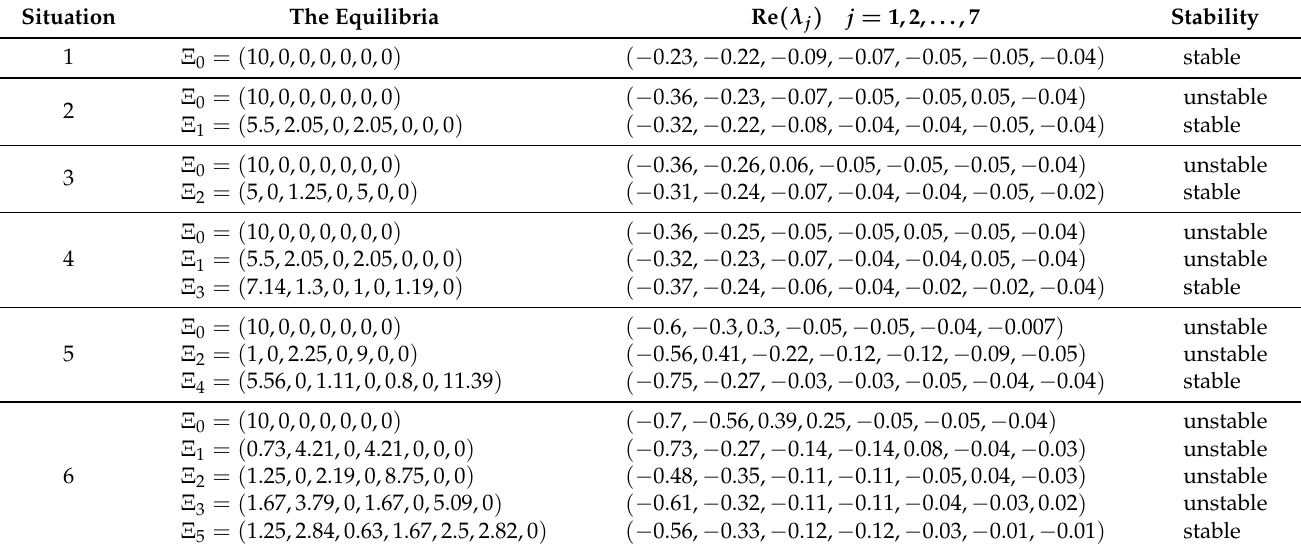
Table 3. Local stability of nonnegative equilibria Ξ i , i = 0,1, . . .